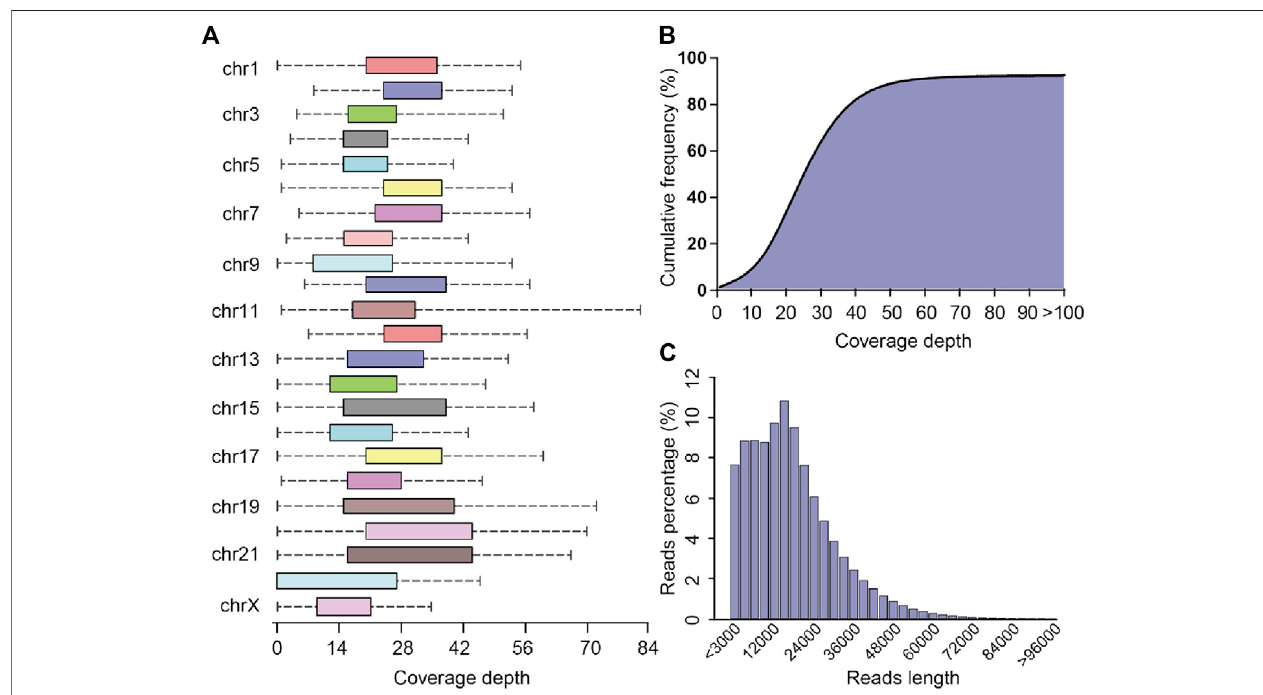
FIGURE 2| Sequencing coverage and reads length distribution plots (A) Box plotof sequencing coverage of each chromosome. (B) Cumulative percentage plots of coverage depth for the whole genome, the x -axis represents the coverage depth, and the y -axis represents the percentage of bases that reach this coverage depth level. (C) Distribution diagram of reads